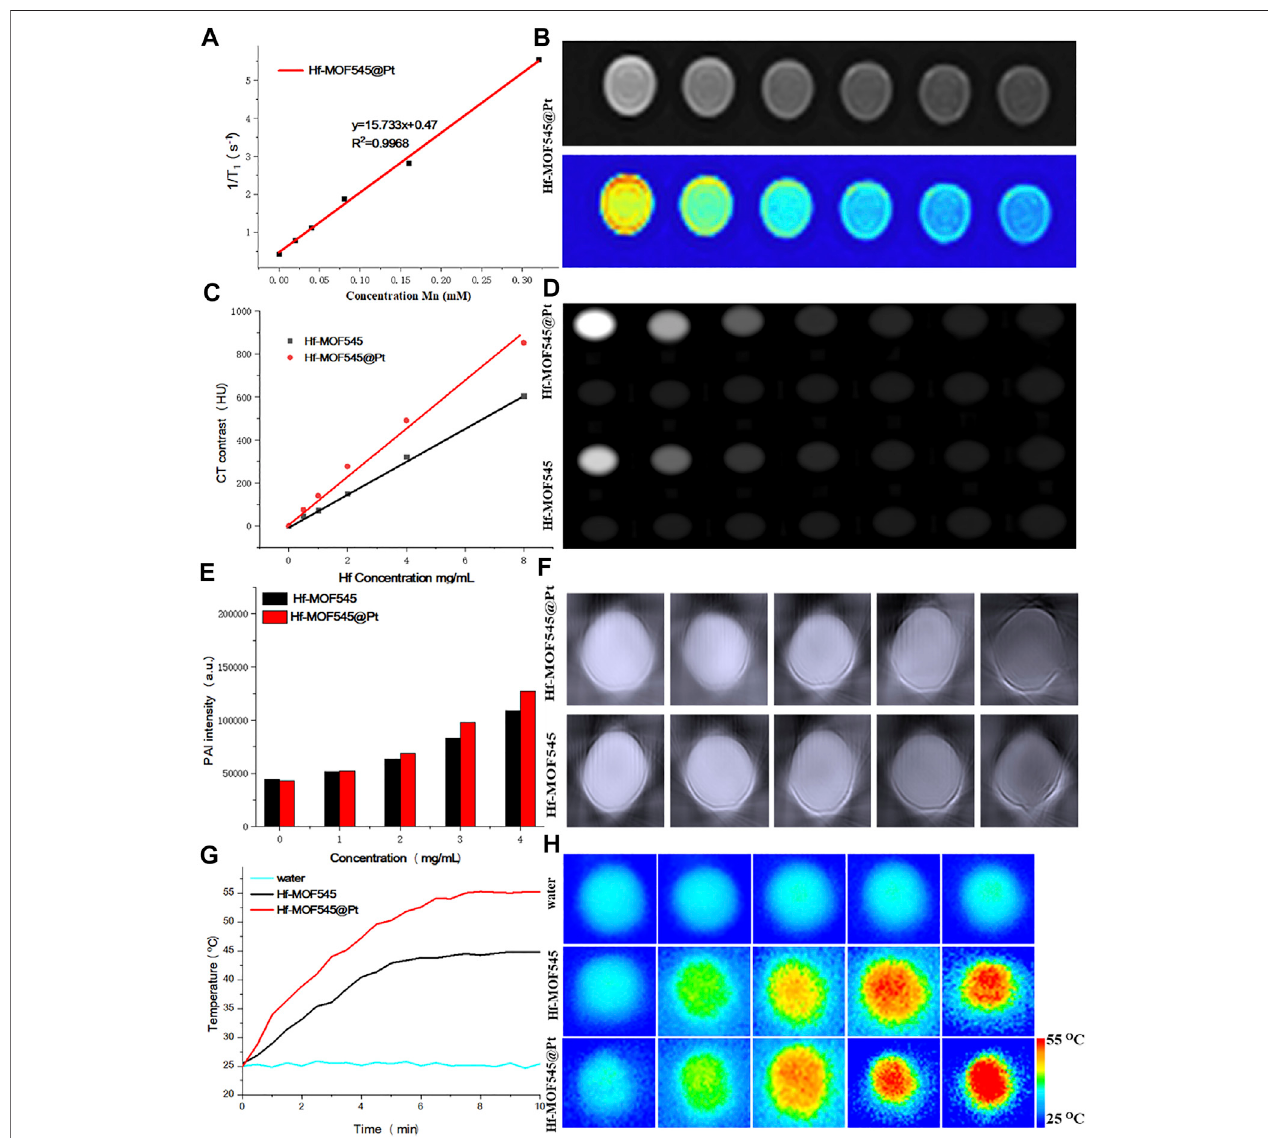
FIGURE 2 | In vitro MRI/CT/PAI characterization of NMOF545 and NMOF545@Pt. (A) T1 relaxation rates of NMOF545@Pt and T1-weighted MR images (B) ; (C) the HU value of NMOF545 and NMOF545@Pt nanocomposites against the Hf concentration and CT images of different concentrations of nanocomposites (D) ; (E) PAI signal intensity changes with the increasing concentrations and the PAI images of two samples (F) ; (G) temperature increasing pro fi les of water, NMOF545 and NMOF545@Pt (200 μ g/ml) using 808 nm NIR laser powers (0.75 W/cm 2 ) for 10 min; and (H) thermal images of different samples for different durations.